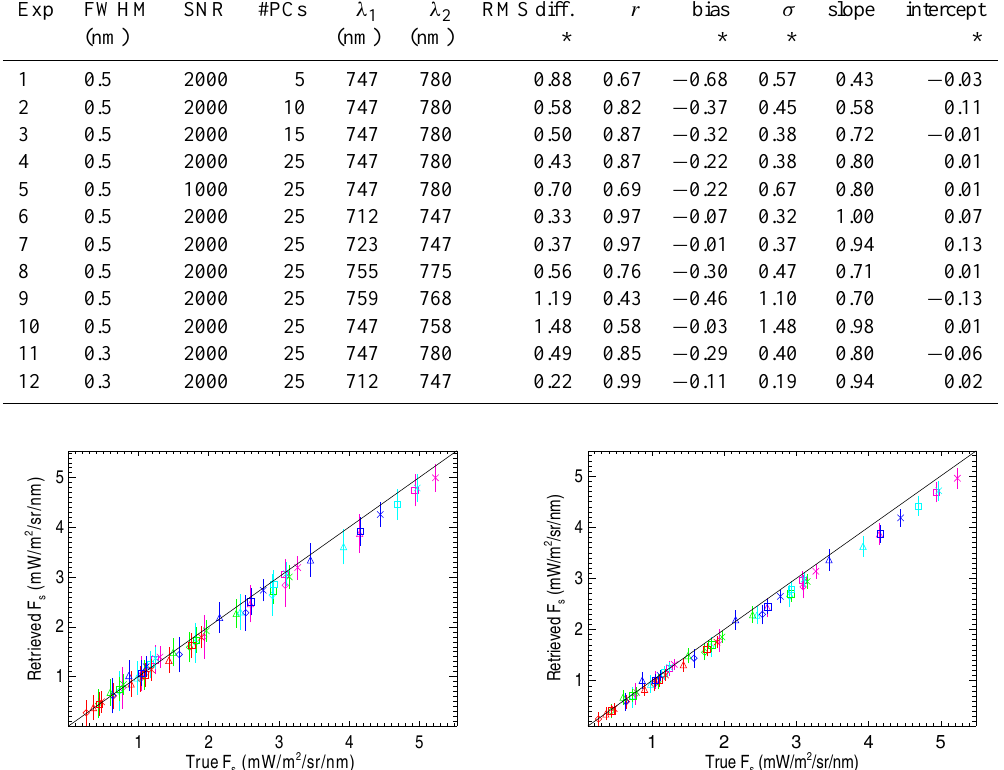
Table 1. Statistical comparison of retrieved versus true values of F s obtained with the simulated testing data set for different experiments (Exp); all fluorescence radiance units (indicated by *) are mWm − 2 nm − 1 sr − 1 . Retrievals are performed for an instrument with a given full-width-at-half-maximum (FWHM) line shape function, signal-to-noise ratio (SNR), number of principal components (#PCs), and fitting window from starting wavelength λ 1 to ending wavelength λ 2 . Statistics given are the root-mean-squared difference (RMS diff.), correlation coefficient ( r ), mean difference (bias) of retrieved minus truth, standard deviation ( σ ), and slope (A) and intercept (B) of a linear fit (retrieved fluorescence = A + B · truth) (last two columns).